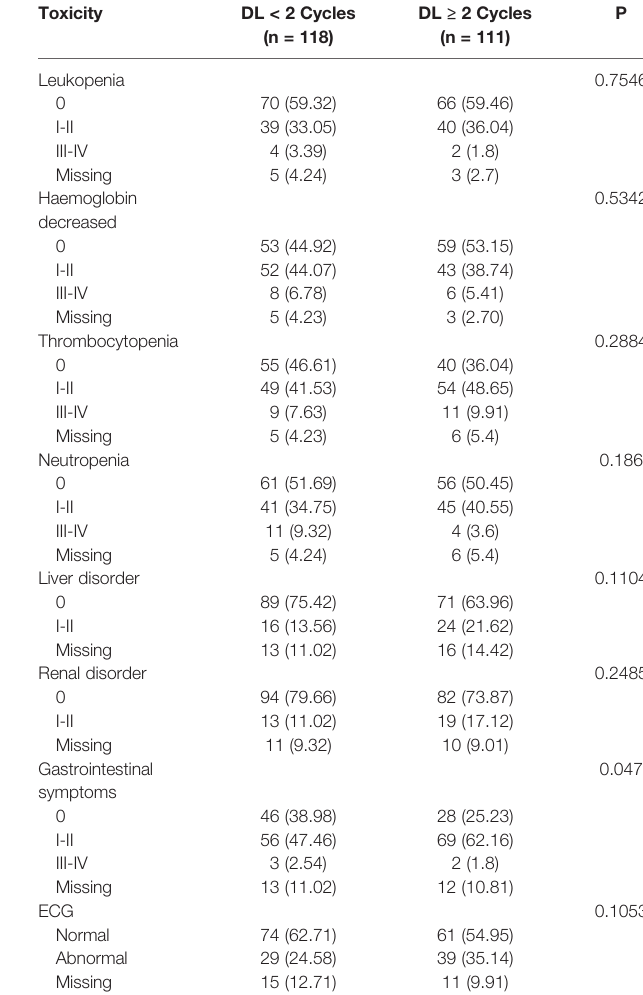
TABLE 2 | Side effects of adjuvant therapy in the matched full cohort. Toxicity DL (n = 229) DC (n = 229) P Leukopenia